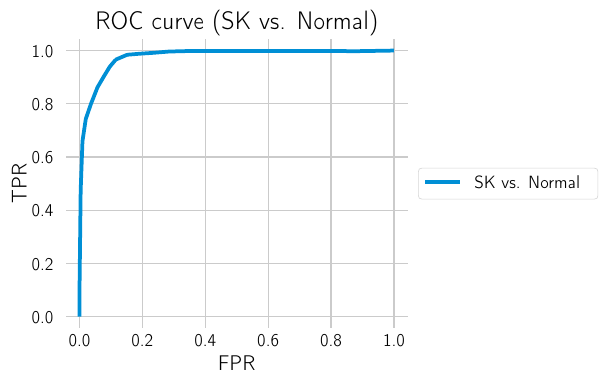
Figure 17. ROC curve for “SK vs. Normal” on the test set from Center